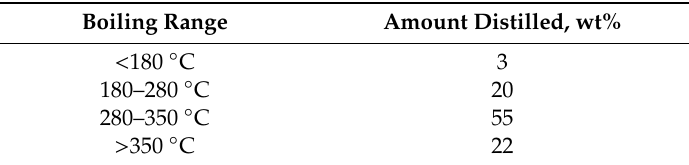
Table 8. Boiling range distribution of the atmospheric gas